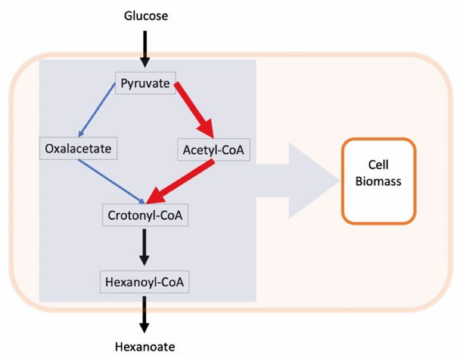
Figure 3. Schematic representation of the branched pathway as related to bacterial growth rate. The orange frame stands for the cell wall separating the intracellular and extracellular